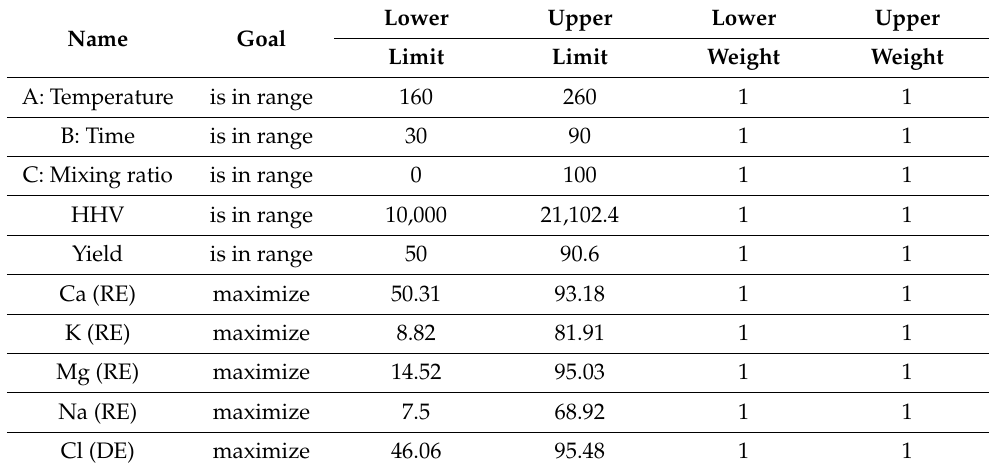
Table 1. Variable constraint table.